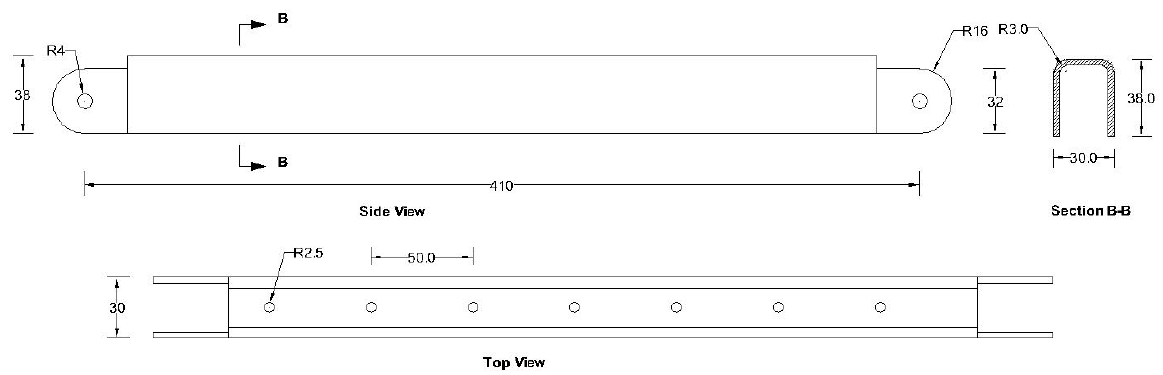
Figure 10. Details of Sidebars (all dimensions are in mm, steel plate gauge 12). Figure 11. Details of main lock channel (all dimensions are in mm, steel plate gauge 11). Figure 12. Details of secondary lock channel (all dimensions are in mm, steel plate gauge 12).